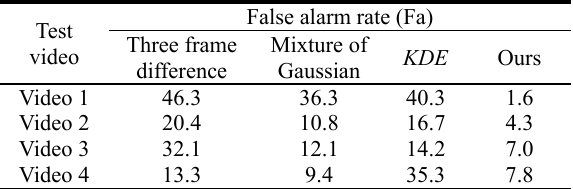
Table 4 False alarm rate (%).